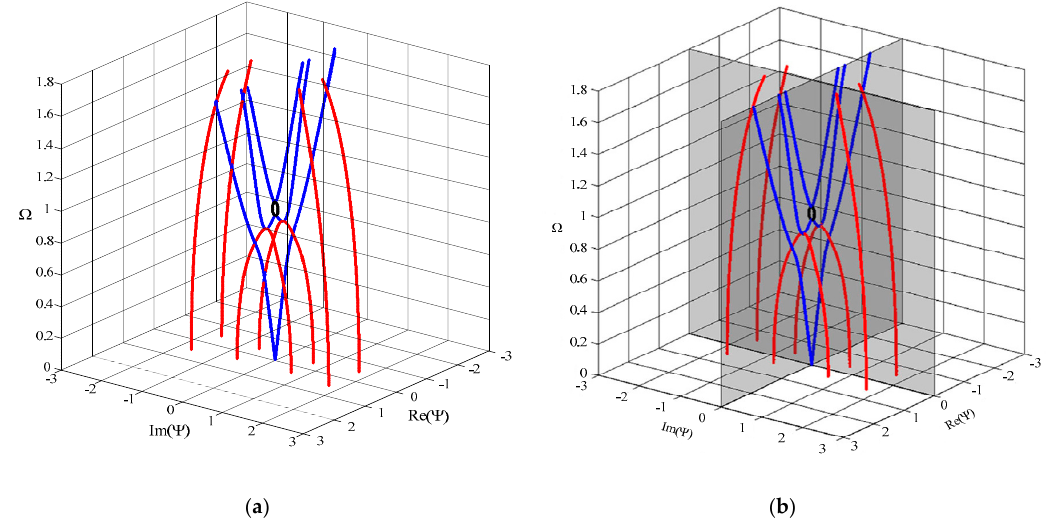
Figure 2. Dispersion curves of first three Lamb modes for a steel plate; real branch in blue, purely imaginary branch in black, complex branch in red. ( a ) Authors’ results, ( b ) Quintanilla et al.’s results from the spectral collocation method.